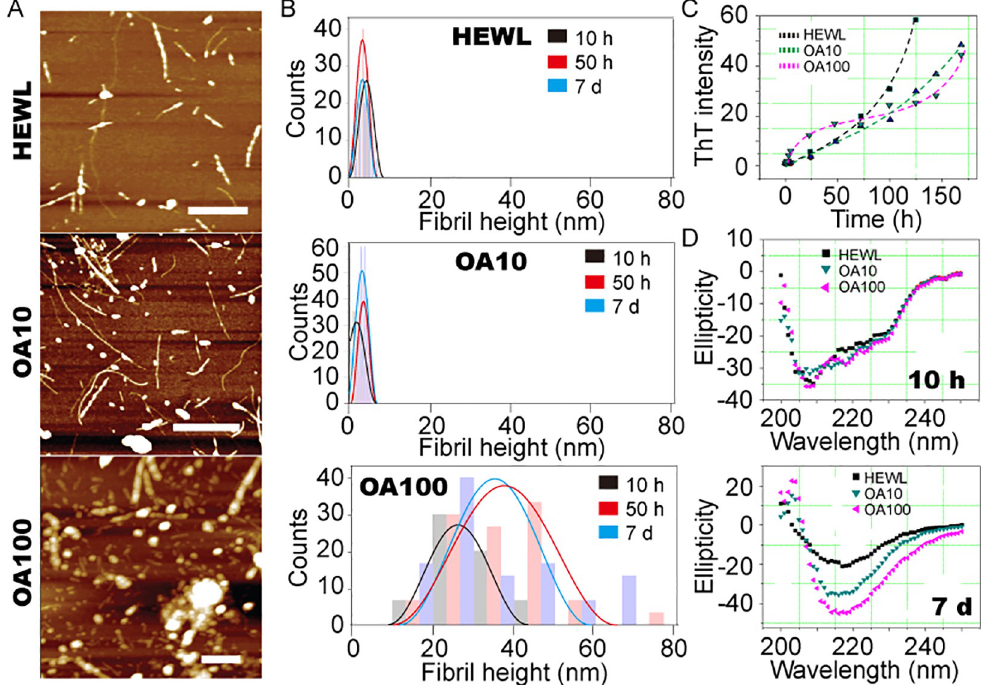
Fig 1. (A) AFM height image of 1.4 mM HEWL only (HEWL, top), 1.4 mM HEWL with 14 mM OA (OA10, middle), and 1.4 mM HEWL with 140 mM OA (OA100, down), after incubation for 1d. Scale bars denote 1000 nm in all images. (B) Height distribution of fibrils obtained by AFM measurement in samples containing only HEWL (HEWL, top), 1.4 mM HEWL with 14 mM OA (OA10, middle) and 1.4 mM HEWL with 140 mM OA (OA100, down). (C) Amyloid formation kinetics of 1.4 mM hen egg white lysozyme (HEWL) with 14mM and 140 mM OA (OA10 and OA100, respectively). (D) Far UV CD spectra of 1.4mM hen egg white lysozyme (HEWL) with OA. All samples are maintained in 20 mM glycine buffer under continuous shaking at 800 rpm, pH 2.3 and 57˚C for up to7